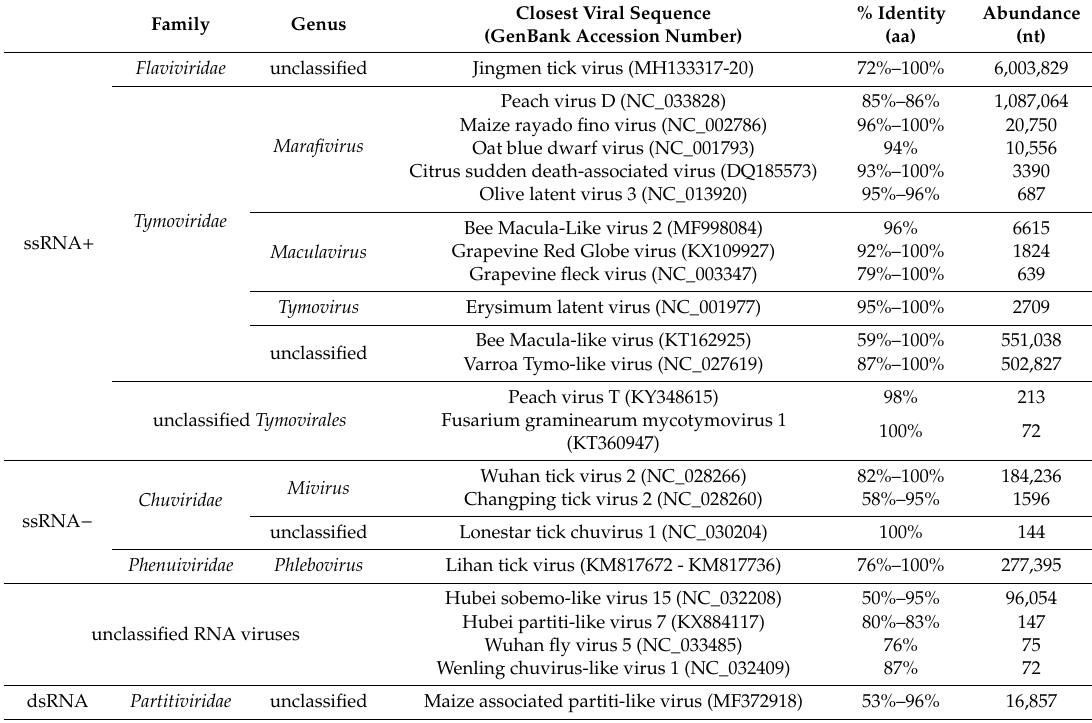
Table 2. Main viral sequences identified by NGS in Caribbean ticks. The quantification of abundance of each viral taxon was obtained by summing the length (in nucleotides) of all sequences being associated to this taxon, weighted by the k -mer coverage of each